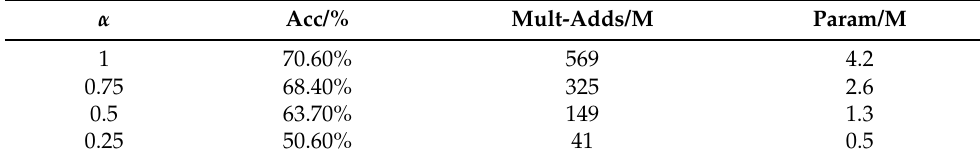
Table 1. The model performance under different width